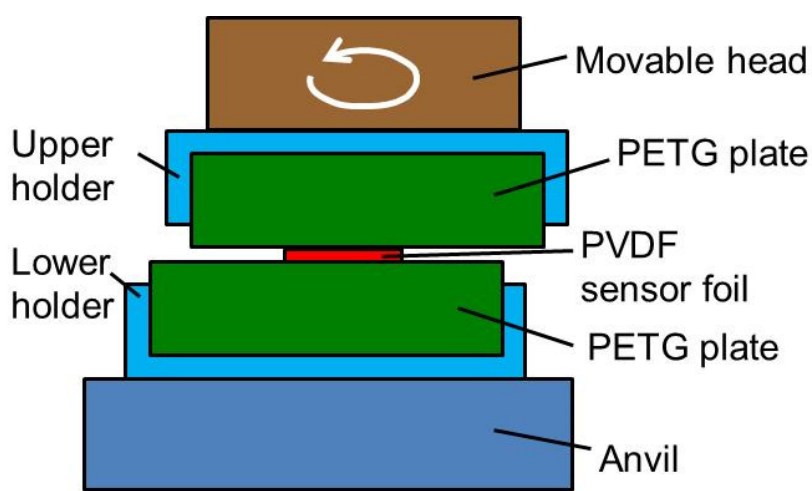
Figure 17. Schematic drawing of the experimental setup in a circular friction welding machine.